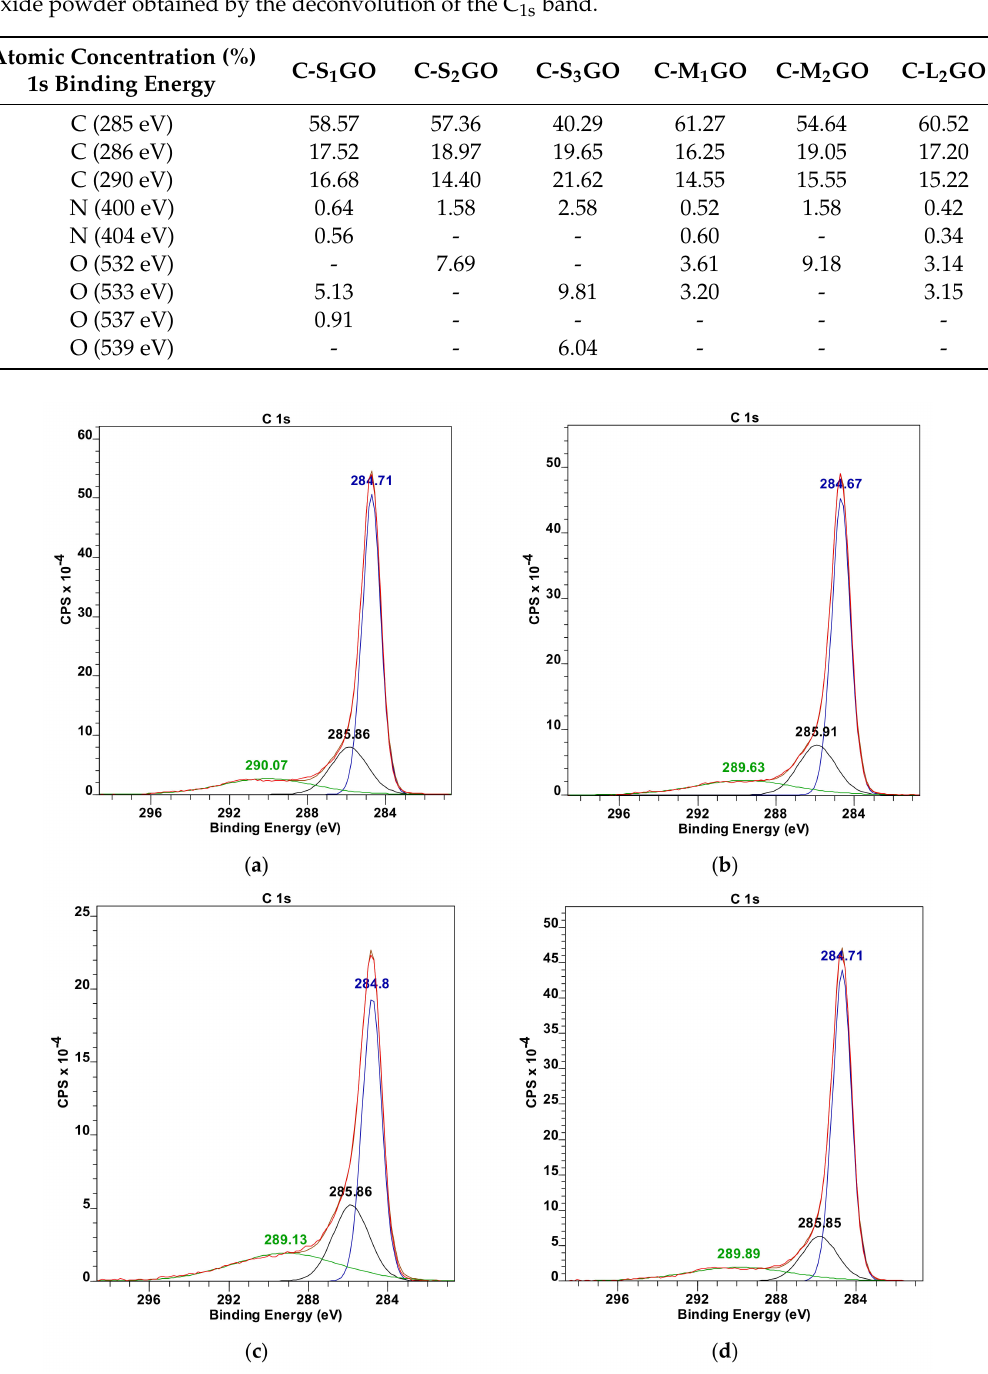
Table 6. Shares of di ff erent types of carbon, nitrogen, and oxygen atoms in the cross-linked graphene oxide powder obtained by the deconvolution of the C 1s band.